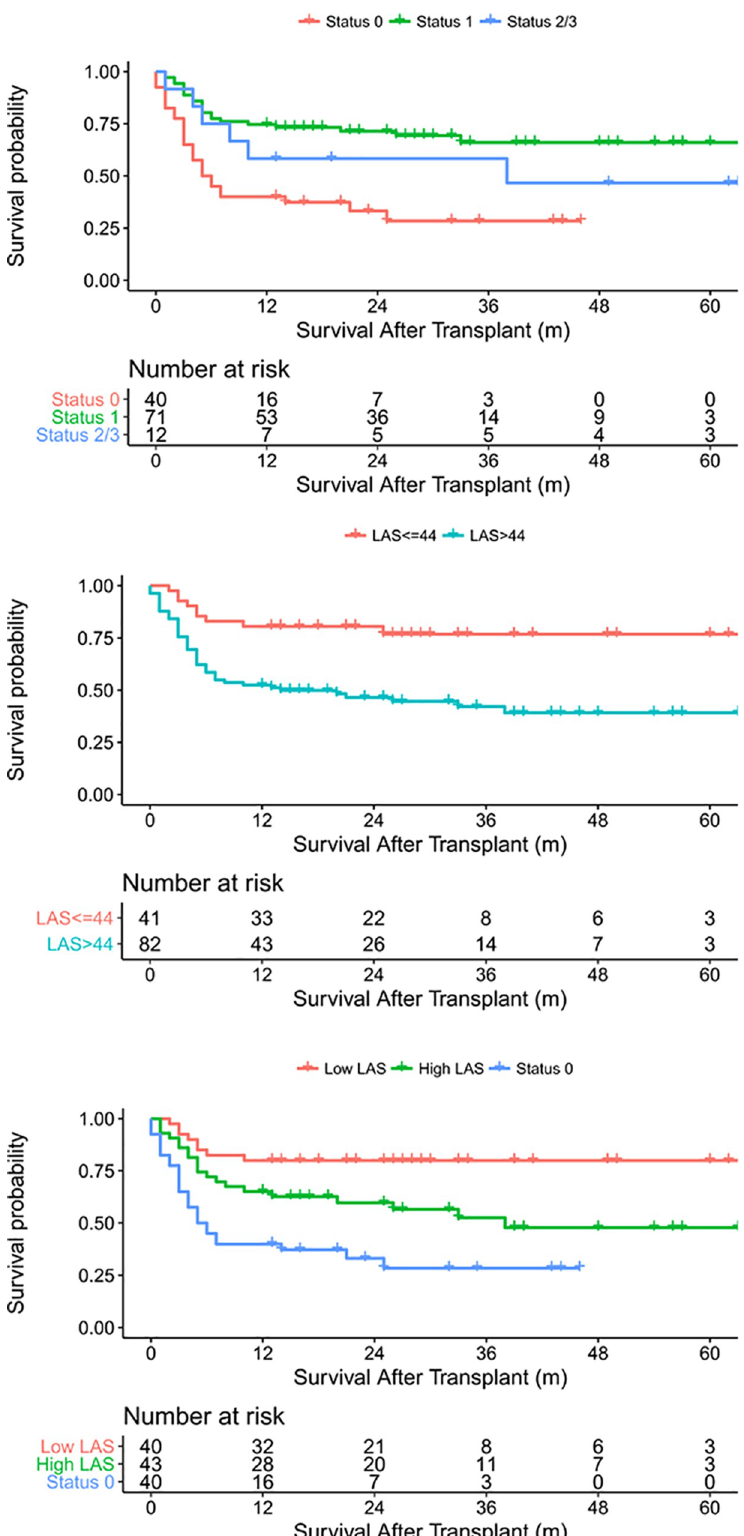
Fig 4. Survival according to urgency status and the lung allocation score. Abbreviation: LAS, lung allocation score.